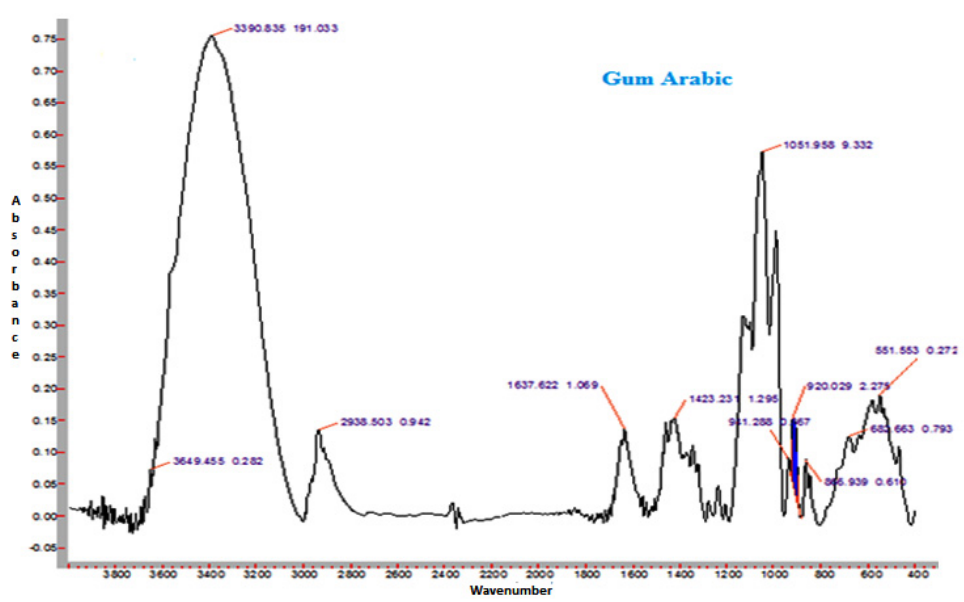
Figure 5 Figure 5. Representative FTIR spectrum of spray-dried nutritionally rich honey powder fortified with gum arabic (GA).